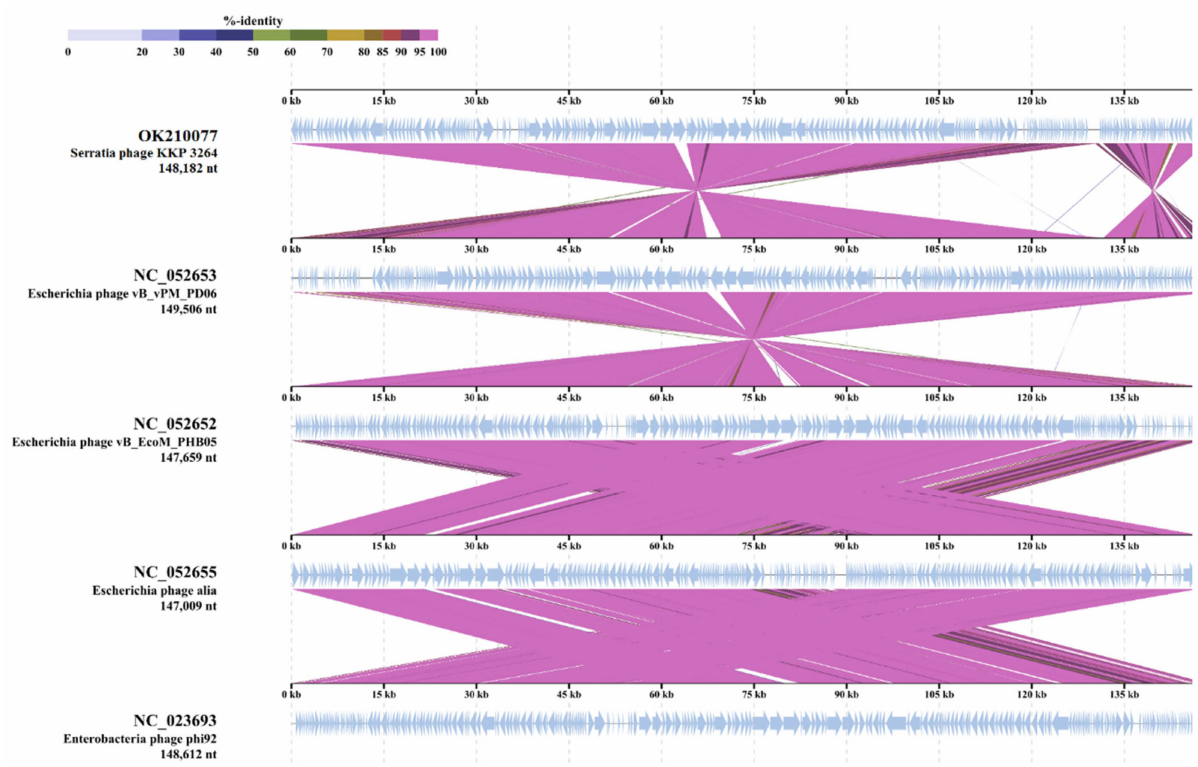
Figure 9. Genome sequence comparison of the Serratia phage KKP 3264 with four other Myoviridae -related phage genomes exhibiting co-linearity detected by TBLASTX using ViPTree server [84]. Homologous regions detected by a TBLASTX search are connected by segments colored based on amino acid identity. The color bar shows the % identity of